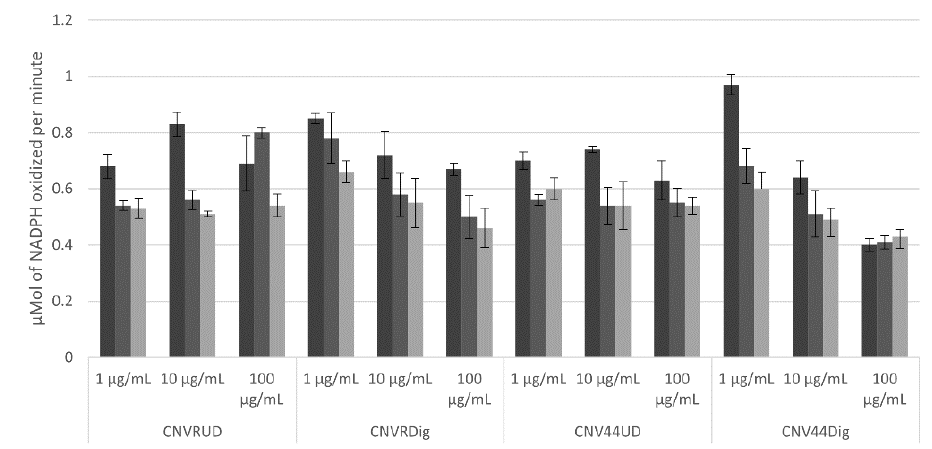
Figure 9. Oxidized NADPH from HMGR in presence of digested and undigested proteins. CNVRUD = Undigested CNVR, CNVRDig = CNVR hydrolyzed, CNV44UD = Undigested CNV44, CNV44Dig = CNV44 hydrolyzed. In dark gray after 10 min, in medium gray after 20 min, and light gray after 30 min.